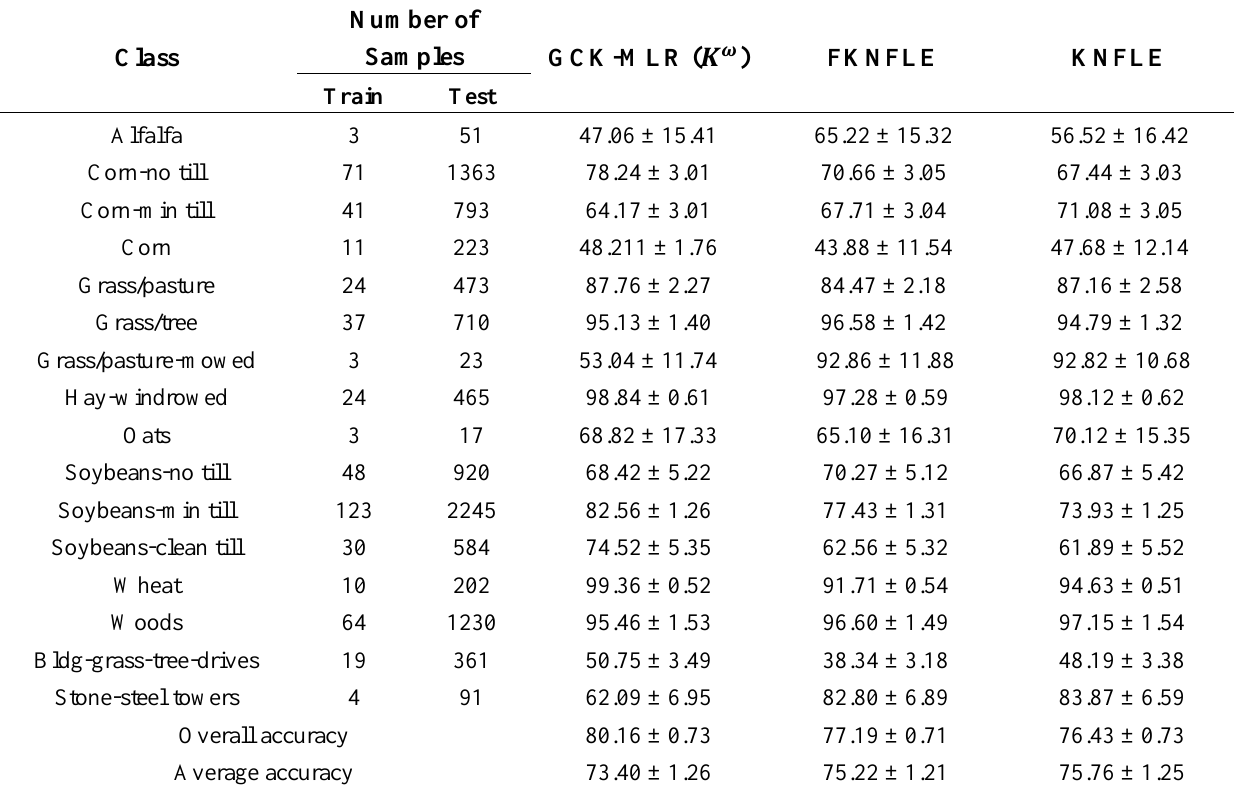
Table 8. The comparison between algorithm GCK-MLR ( 𝐾 𝜔 ) and the proposed method for dataset IPS of 16 classes (in percent).